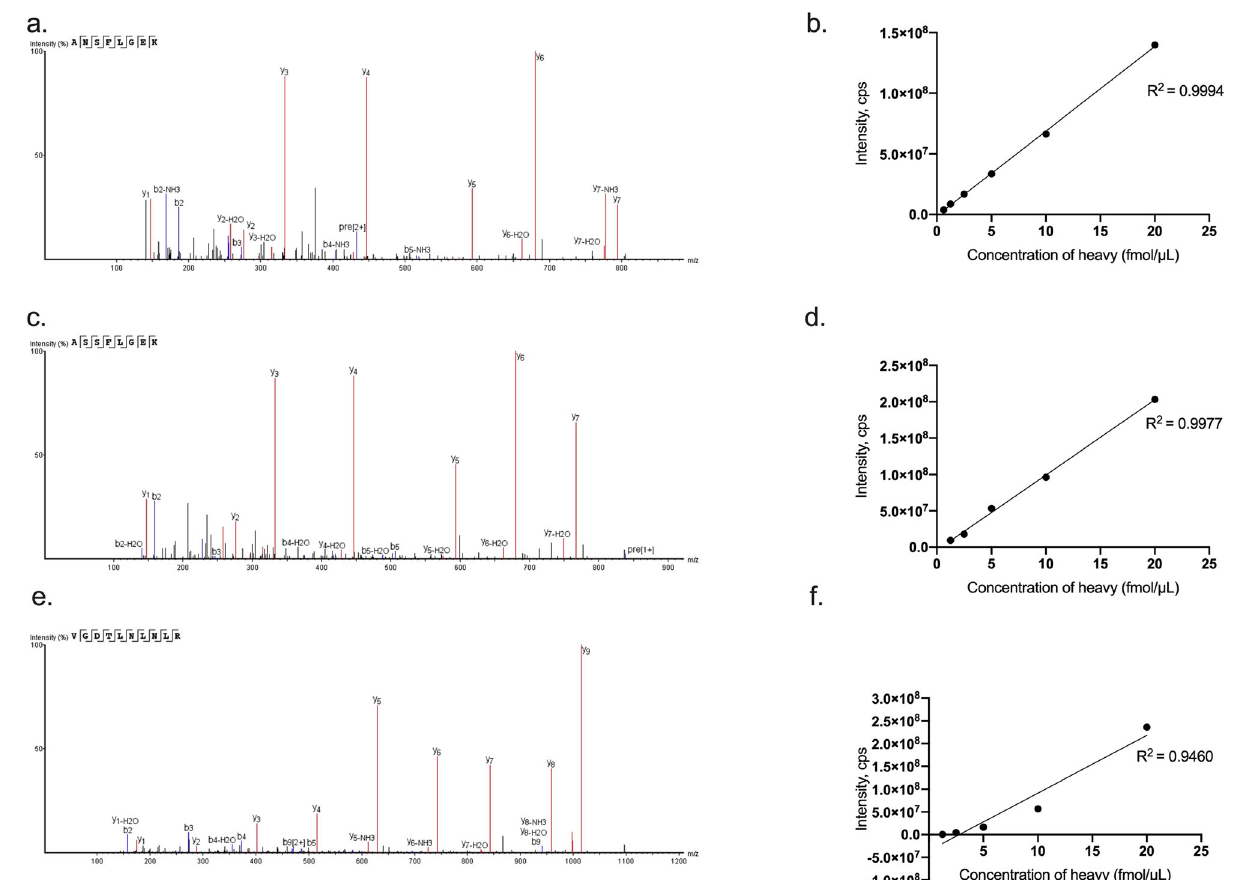
Fig. 5 | Representativevalidation spectra and linearity graphsfor C4 peptides. ValidationspectrafortheuniquepeptidesusedtodetectC4A( a ),C4B( c )andtotal C4(tC4)( e )inhumancerebrospinal fl uid(CSF). b , d , f displaylinearrangeofheavy peptides in pooled CSF digest for C4A, C4B, and tC4, respectively. Spiked pooled